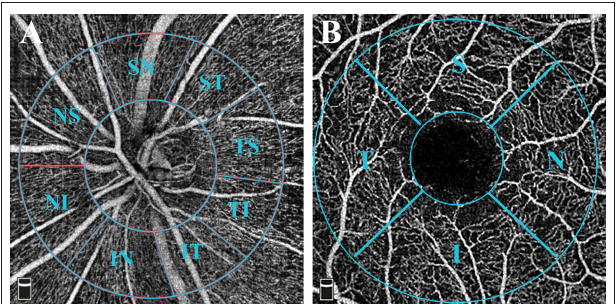
FIGURE 1 | OCTA measurement of vessel density. (A) Angio Disc 4.5 × 4.5mm scan (left eye). The inner-circle represented the inside disc sector. The peripapillary region is defined by a 2-mm and a 4-mm ring centered on the disc. The image presented the peripapillary sectors according to a modified Garway-Heath method. The eight sectors included Nasal Superior (NS), Nasal Inferior (NI), Inferior Nasal (IN), Inferior Temporal (IT), Temporal Inferior (TI), Temporal Superior (TS), Superior Temporal (ST), and Superior Nasal (SN) regions. (B) Angio Retina 3 × 3mm scan (right eye). The 1-mm circle in the center referred to the fovea. The parafovea region was defined as a 1 mm-wide annulus extending from a 1mm circle centered on the fovea. The central foveal and parafoveal subfields were divided in accordance with the early treatment of diabetic retinopathy study (ETDRS) retinal grid definition, which included Nasal (N), Superior (S), Temporal (T), and Inferior (I) regions.